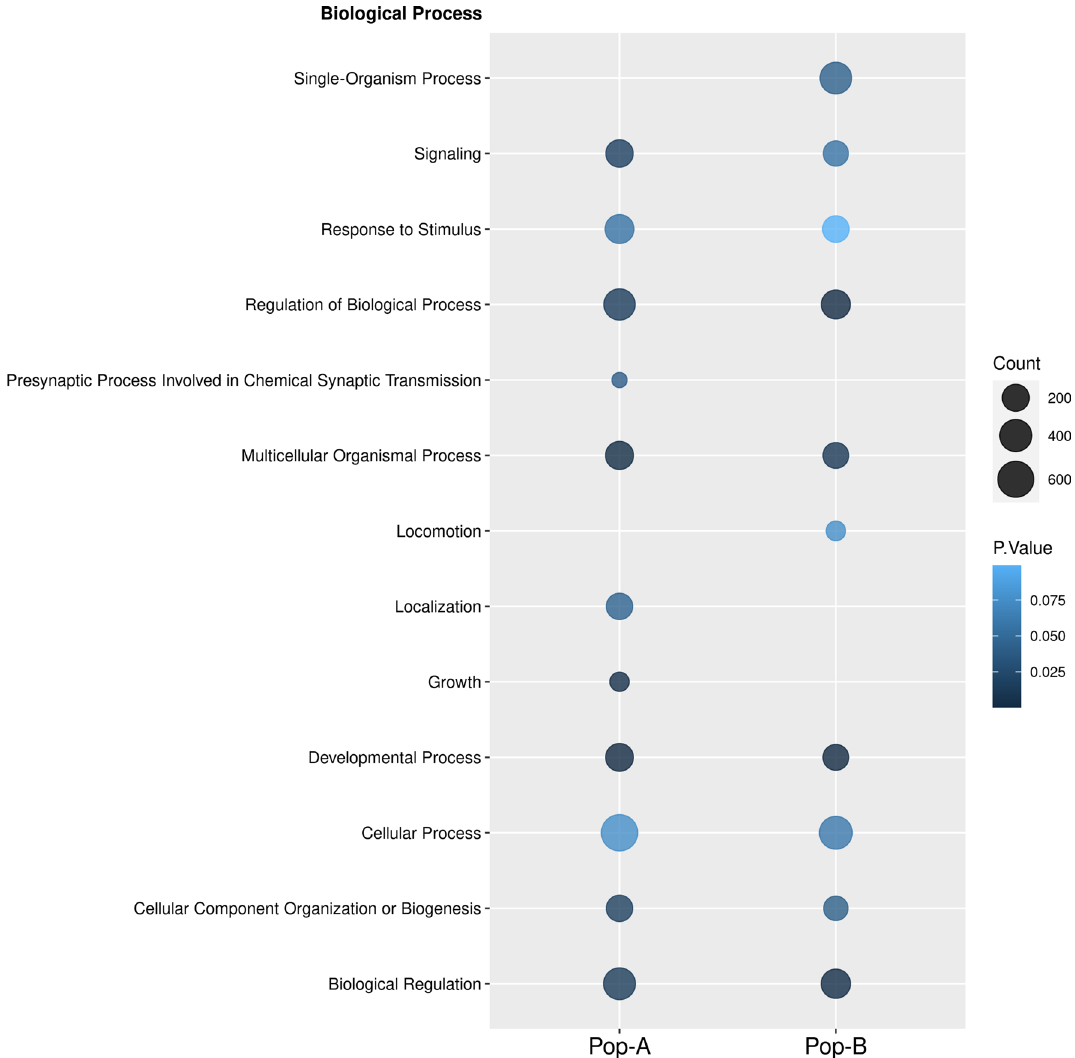
Figure 6. Functional annotation of candidate selective sweeps genes. Gene ontology (GO) analysis performed for Biological process. Color intensity of circle shows the significance of GO term and the size of the circle represents the number of genes associated with the GO